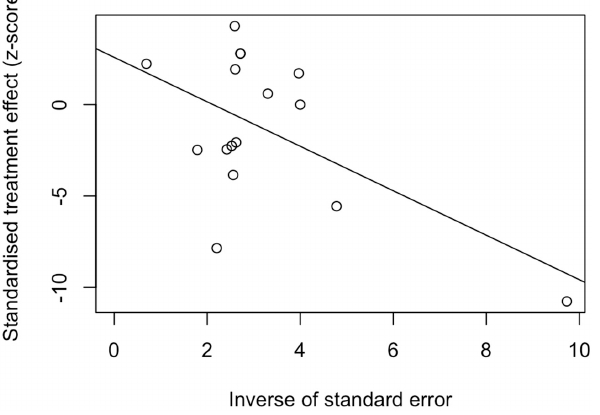
Figure 6. Radial plots for estimates included in the meta-analysis. Visual inspection reported all the estimates as substantially scattered across the regression line, suggesting no significant small study effect.